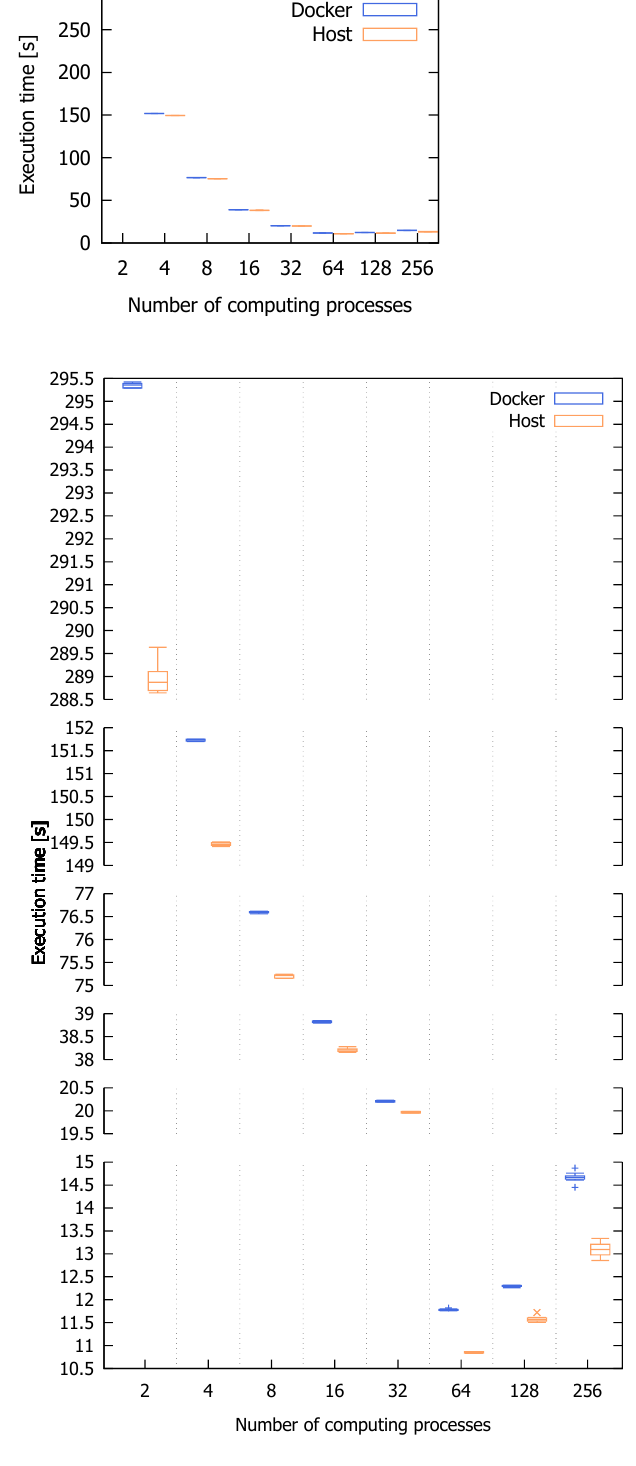
Figure 4. Execution times for MasterSlave, -O2 compilation flag; boxplot notation: medians, Q1 and Q3, max(Q1 − 1.5IQR, minimum) and min(Q3+1.5IQR, maximum) as well as potential outliers (+ for Docker, x for